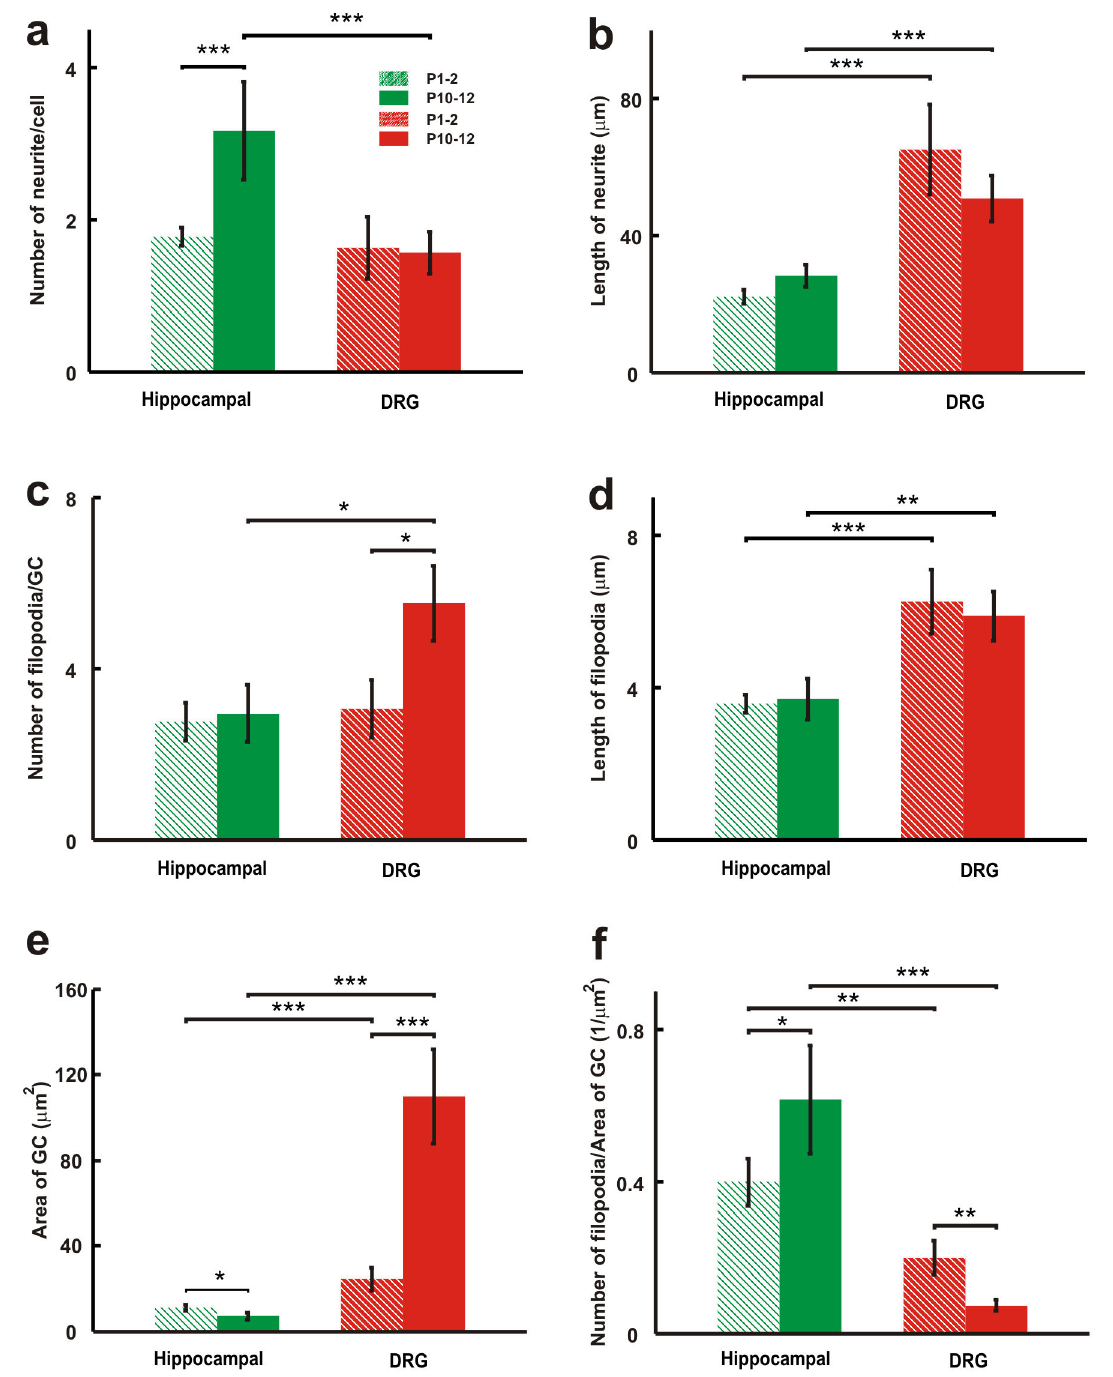
Figure 6. Differences in the morphology of DRG and hippocampal neurites and GCs. ( a ) Average number of neurites emerging from hippocampal and DRG soma. ( b ) Average neurite lengths from the tip of each neurite to the edge of the hippocampal and DRG soma. ( c ) Average number of filopodia emerging from hippocampal and DRG GCs. ( d ) Average filopodium lengths from the tip of each filopodia to the edge of the hippocampal and DRG GCs. ( e ) Average area of hippocampal and DRG GCs. ( f ) Ratio of number of filopodia and area of GC in hippocampal and DRG GCs. In all panels solid bars refer to P10-P12 neurons and striped bars indicate the P1-P2 neurons. Data are shown as mean ± SE. Significance indicates p < 0.05, p < 0.01 and p < 0.001 (*, **, *** respectively, Student’s t-test).